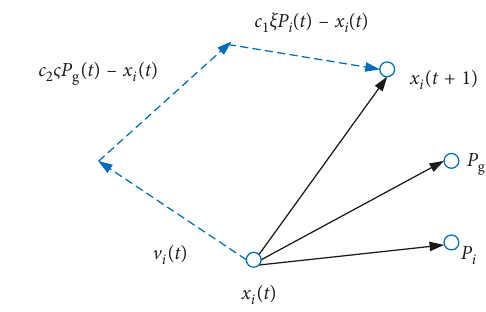
Figure 9: Principle of particle